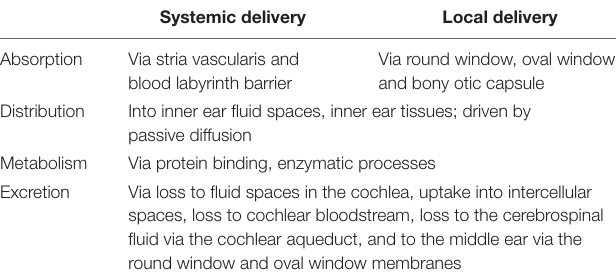
TABLE 1 | Pharmacokinetics of the inner